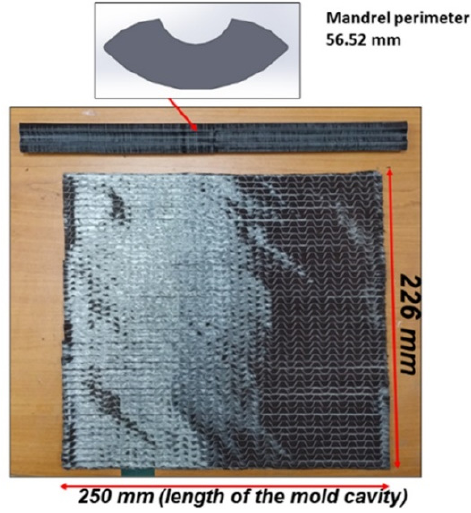
Figure 6. Section, mandrel, and preform dimensions.